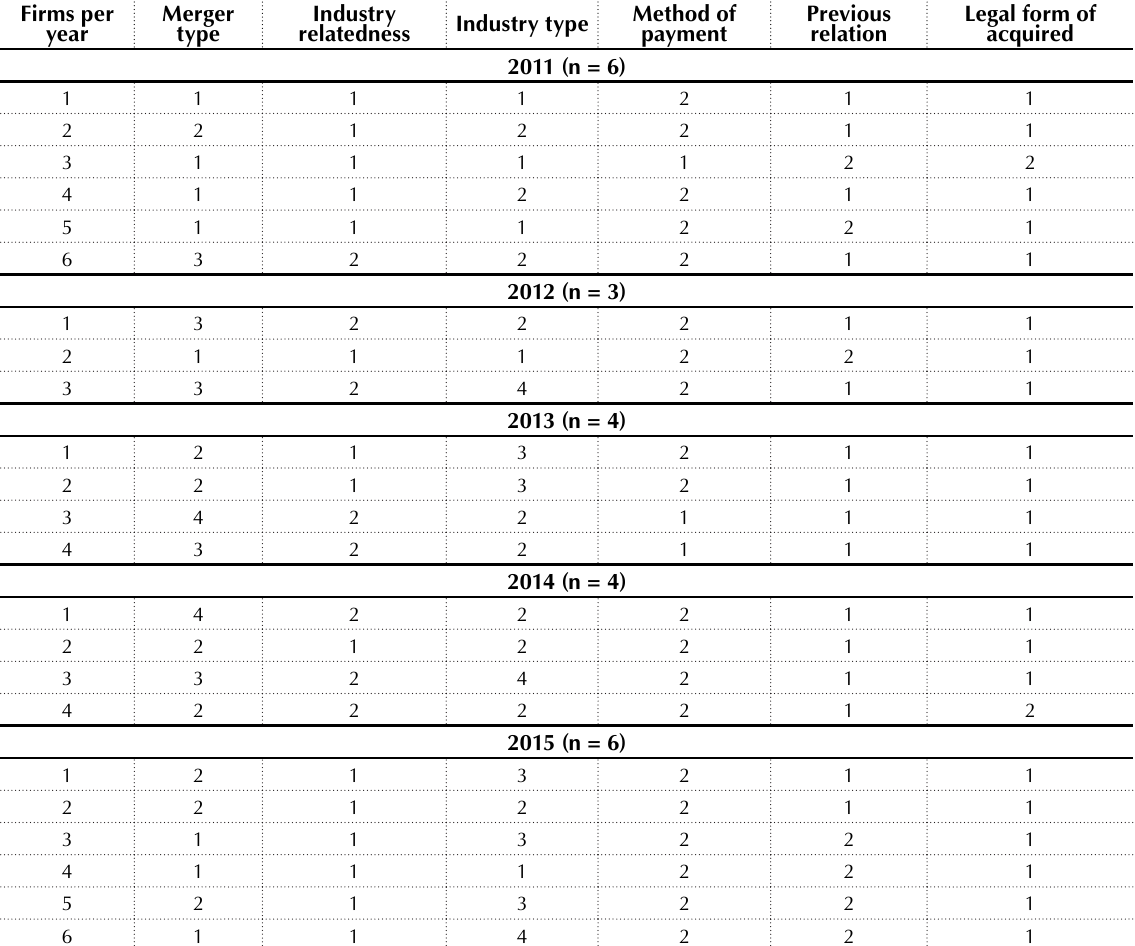
Table 2. Merger characteristics (qualitative variables) of the sample